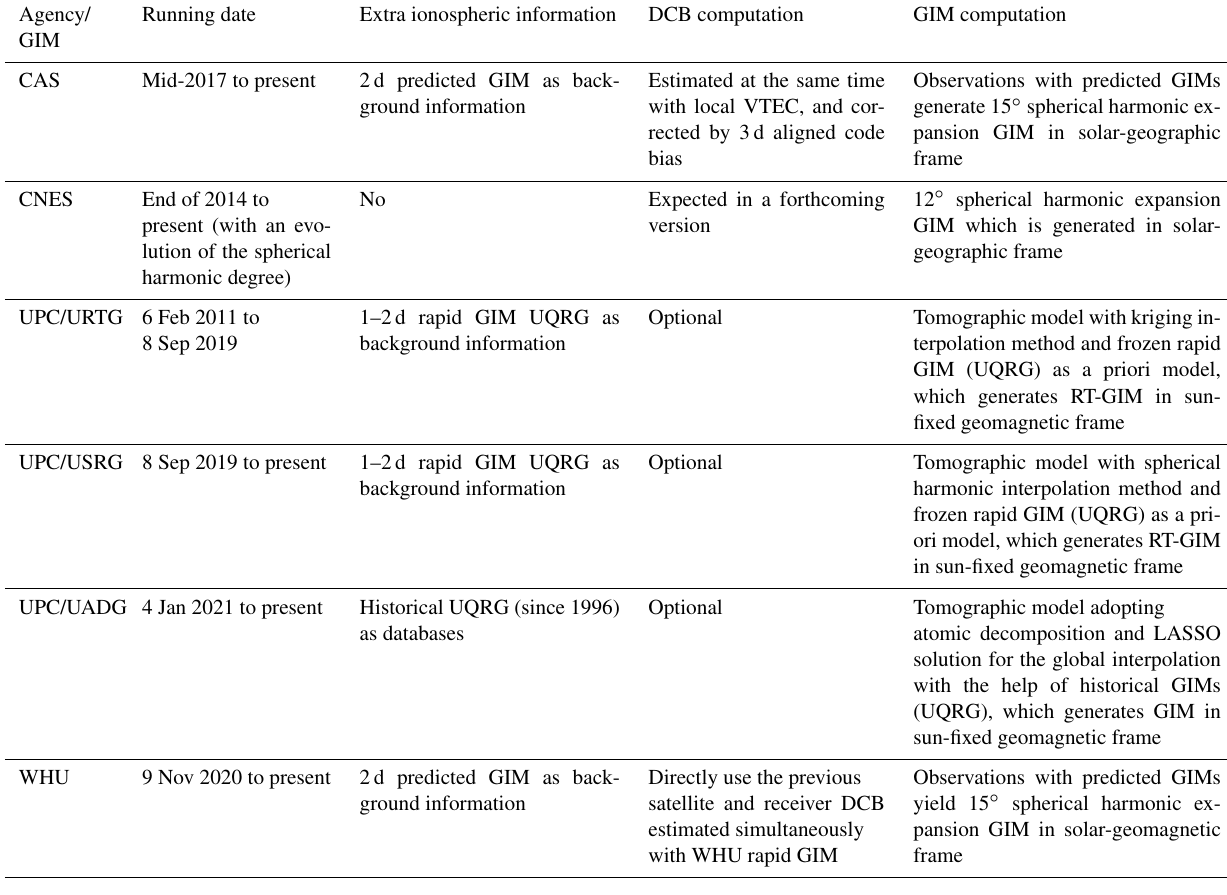
Table 1. The brief summary of different IGS RT-GIMs.